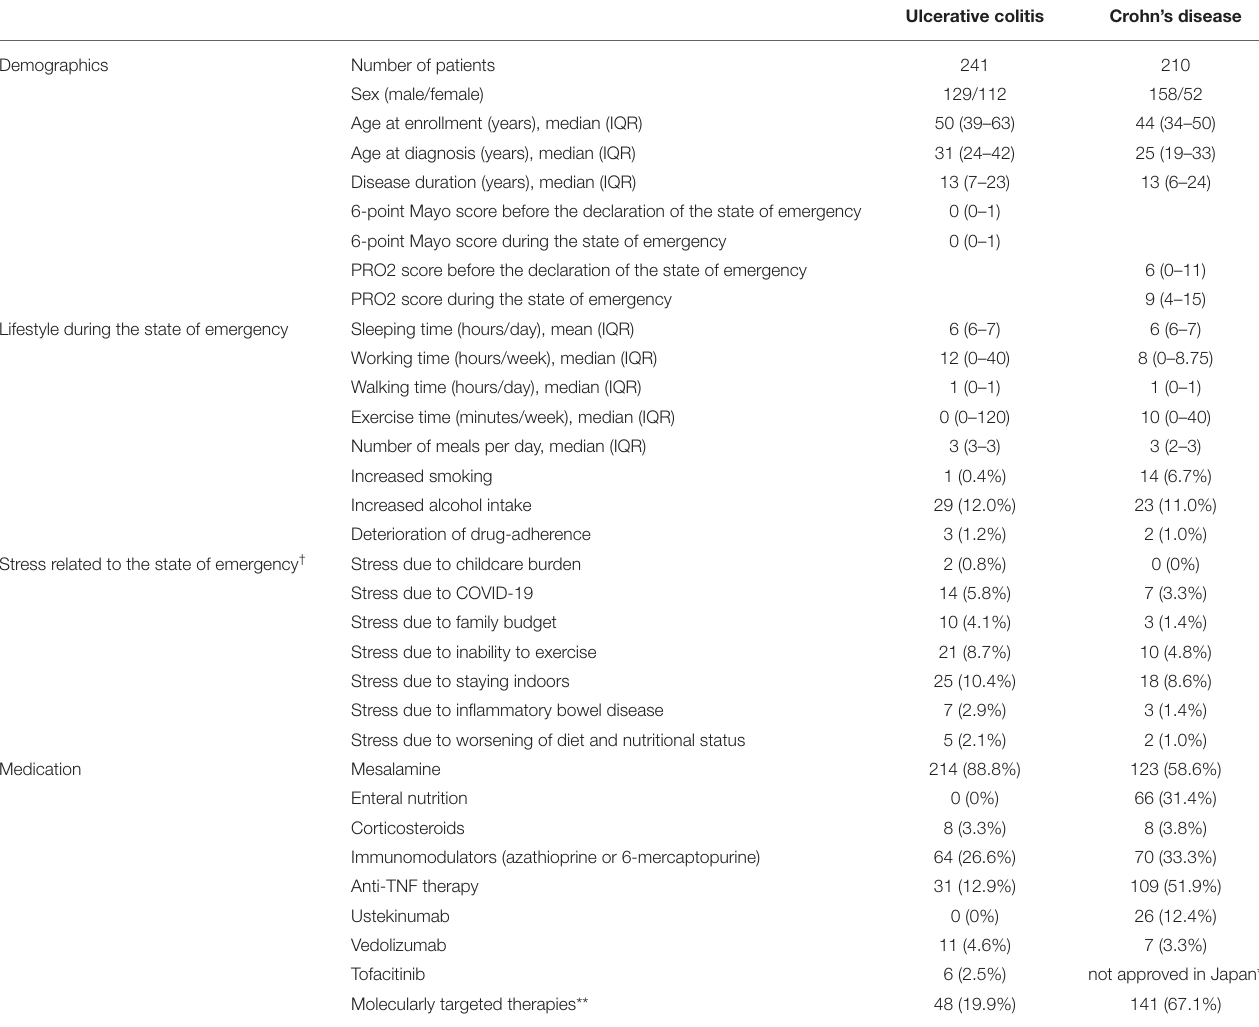
TABLE 1 | Demographic data and disease-related variables of